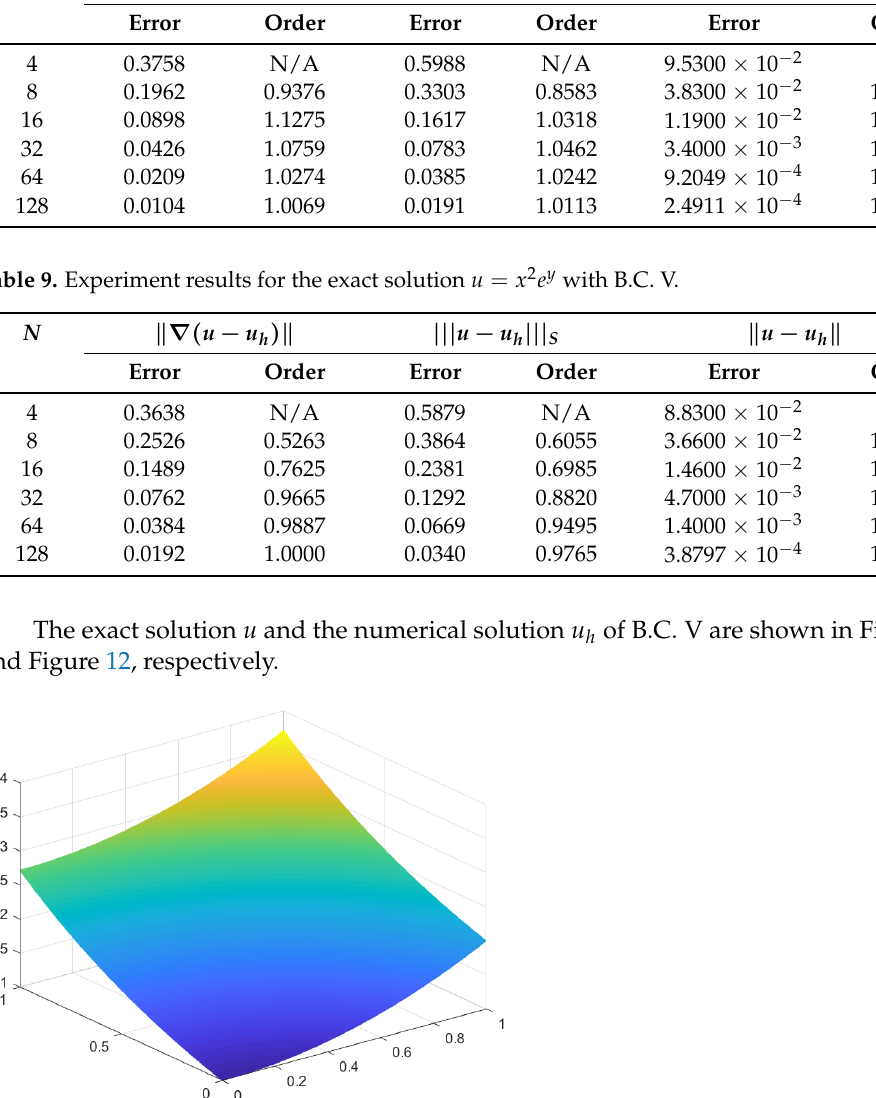
Figure 11. Exact solution u = x 2 + e y Figure 11. exact solution u = x 2 + e y Figure 12. numerical solution u h of B.C. V